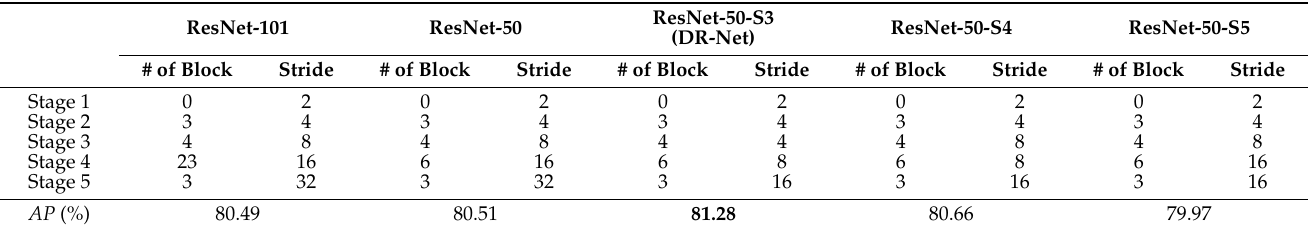
Table 3. Architectures of different backbones and detection results on the UED